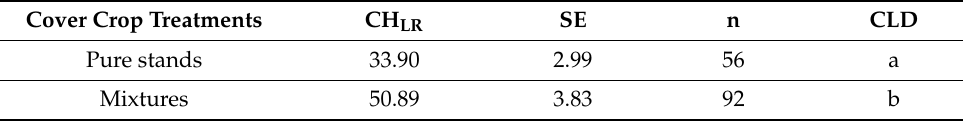
Figure A1. Linear relationship between canopy height from low-resolution UAV mission calculated from ( A ) 90th percentile (CH 0.9 ) and ( B ) 99th percentile (CH 0.99 ) and manual height measurement with a ruler-based method (CH Ruler ) of cover-crop treatments, n = 148. Table A2. Comparison of mean canopy height derived from low-resolution UAV-mission (CH LR ) between the pure stand cover crops and cover crop mixtures, standard error (SE), and compact letter display (CLD) indicating significant differences among the treatments according to Tukey’s test at p <